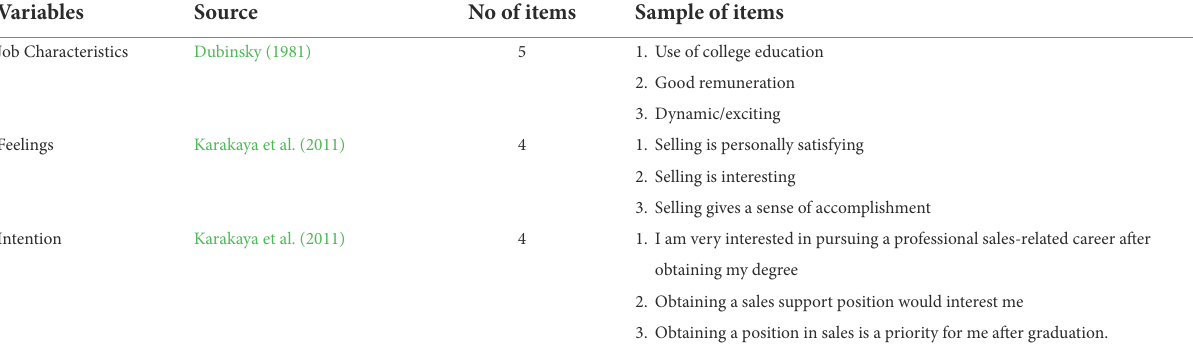
TABLE 1 Sample of measurement items.